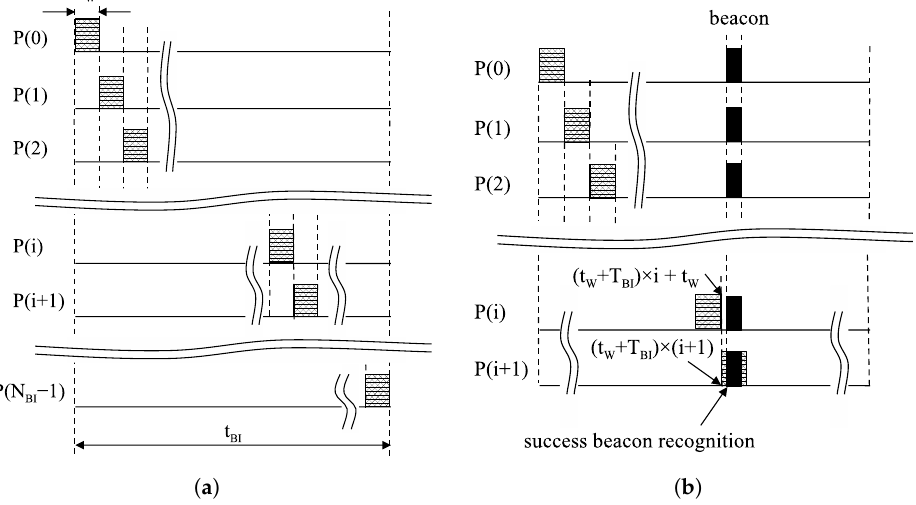
Figure 4. Operation of a proposed moving window: ( a ) Design of the proposed moving window; ( b ) An example of success in beacon